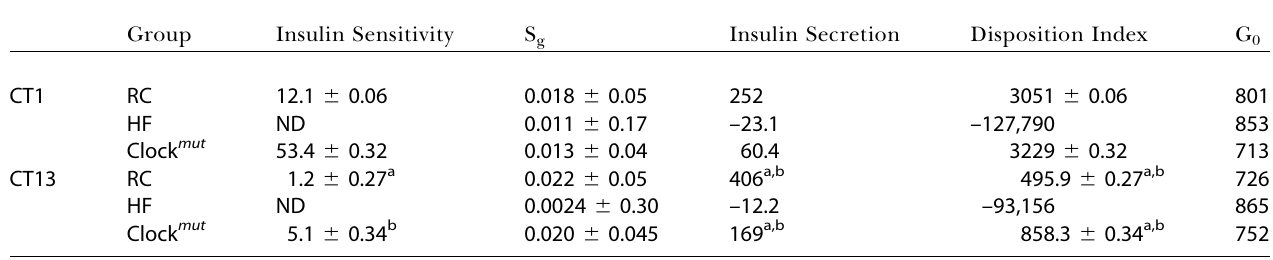
Table 2. Indices of Noninsulin- and Insulin-Mediated Parameters of Glucose Disposal Derived from Modelling of FSIGT Data at CT1 and